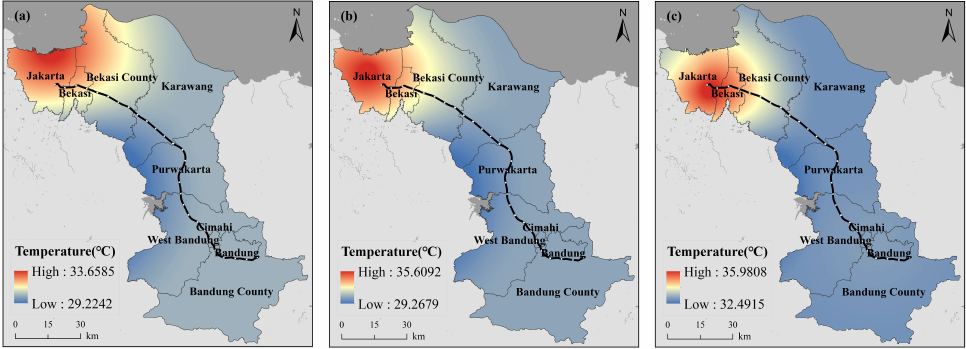
Figure A2. Map of the daily maximum temperature (( a ) 4 September 2005, ( b ) 13 September 2014, ( c ) 11 September 2019).